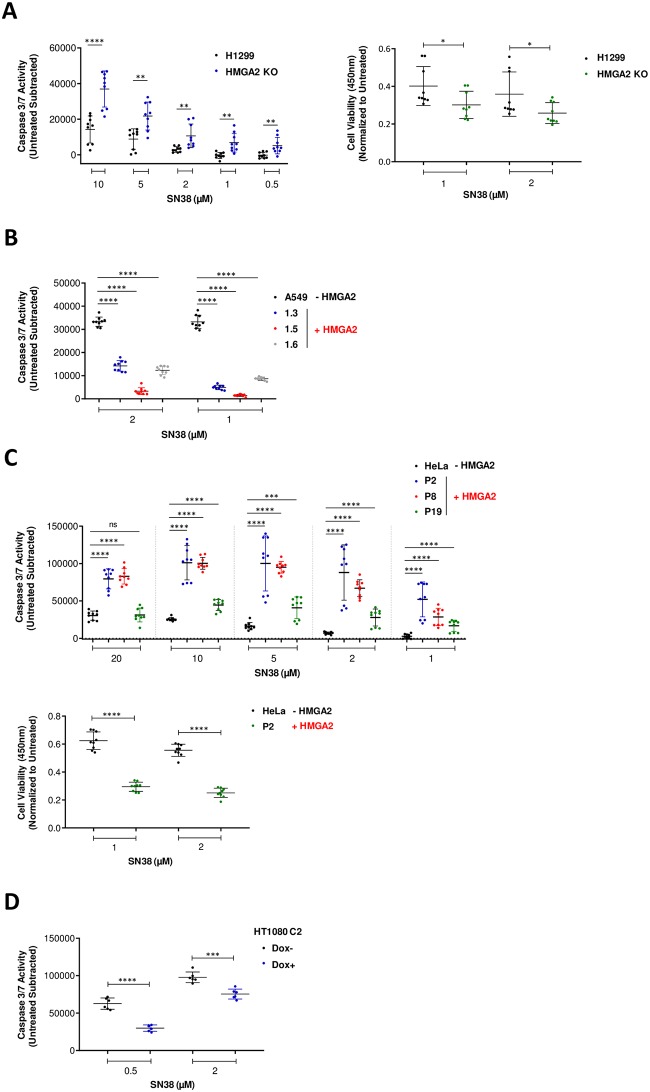
Caspase 3/7 activities correspond with the generation of 30–100 kb fragments in response to SN38 treatment.(A) Caspase 3/7 activity (left panel) in H1299 cells (parental and HMGA2 KO) after SN38 treatment at indicated doses for 24 h and cell survival (CCK8) assay (right panel) with H1299 and HMGA2 KO cells after treatment with SN38 for 48 h (n = 3 independent experiments with 3 technical replicates in each). Mean of untreated triplicates used for normalization. Error bars show SD. Unpaired two-tailed t-tests. ** p < 0.01, **** p < 0.0001. (B) Caspase 3/7 activity in A549 cells (parental and three recombinant human HMGA2-expressing cell lines) after SN38 treatment at indicated doses for 24 h (n = 3 independent experiments with 3 technical replicates in each). Mean of untreated triplicates used for normalization. Error bars show SD. Unpaired two-tailed t-tests. **** p < 0.0001. (C) Caspase 3/7 activity (top panel) in HeLa cells (parental and three recombinant human HMGA2-expressing cell lines) after SN38 treatment at indicated doses for 24 h and cell survival (CCK8) assay (bottom panel) with HeLa and P2 cells (recombinant HMGA2 expressing cell line) after treatment with SN38 for 48 h (n = 3 independent experiments with 3 technical replicates in each). Mean of untreated triplicates used for normalization. Error bars show SD. Unpaired two-tailed t-tests. *** p < 0.001, **** p < 0.0001. (D) Caspase 3/7 activity in HT1080 C2 cells (Dox-/+) after SN38 treatment at indicated doses for 24 h (n = 2 independent experiments with 3 technical replicates in each). Mean of untreated triplicates used for normalization. Error bars show SD. Unpaired two-tailed t-tests. *** p < 0.001, **** p < 0.0001.